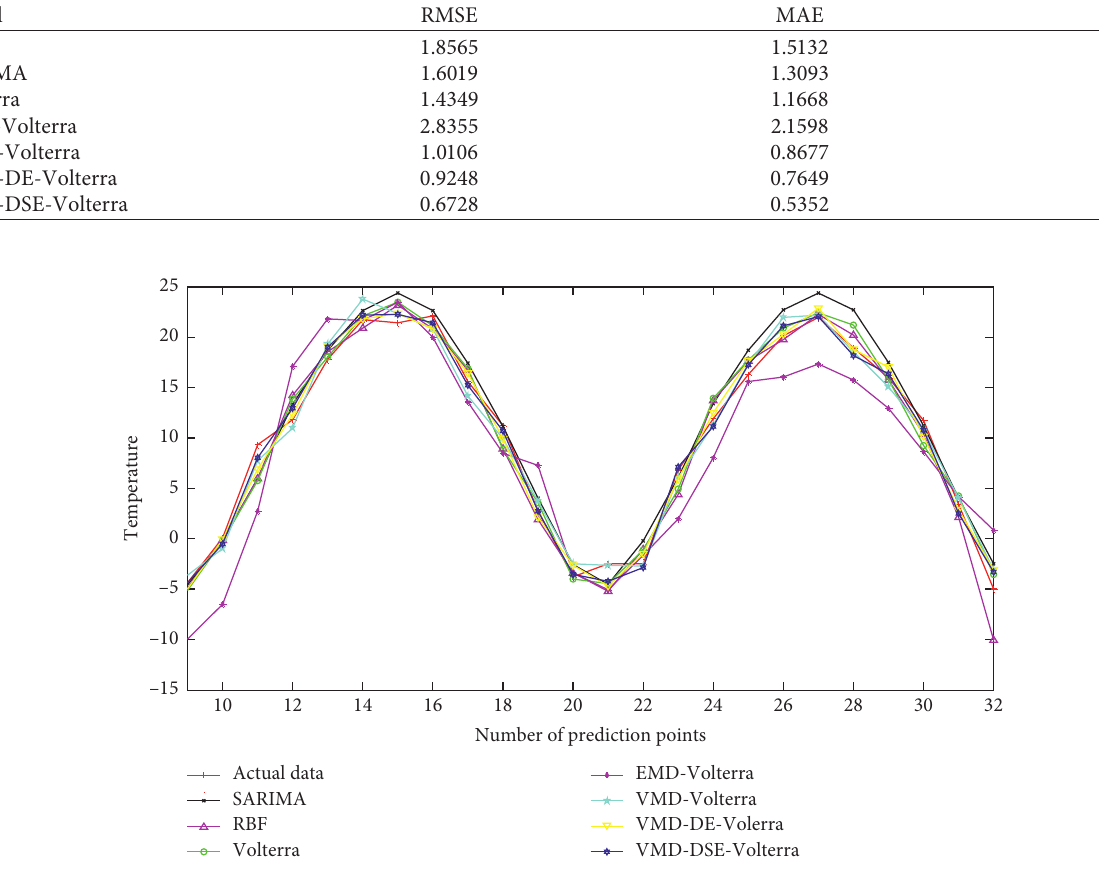
Figure 13: Local enlargement of prediction results for each model in Yan’an.